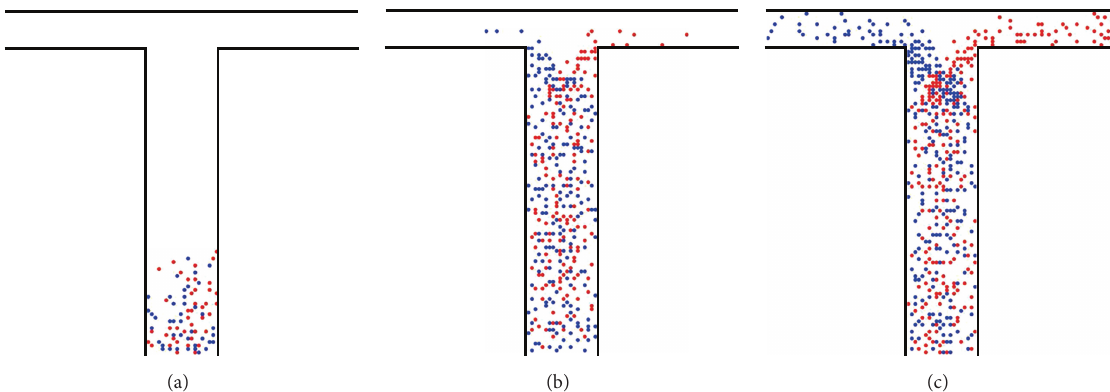
Figure 7: The simulation of separating pedestrian flow without guide sign. (a) LP and RP are generated at the down origin of main passage; (b) LP and RP arrive at the waving zone and interweave; (c) LP and RP arrive at the exit and walk away.